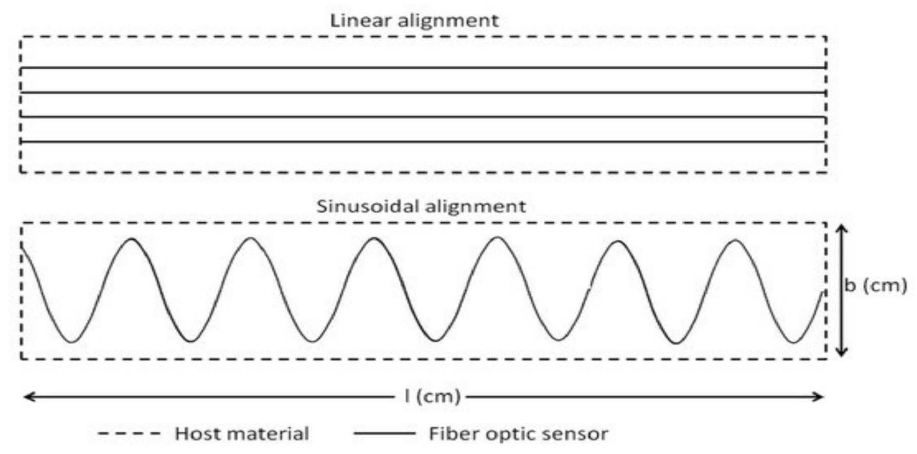
Figure 2. Illustration of straight and sinusoidal Fiber FOS placement strategies [1–4].